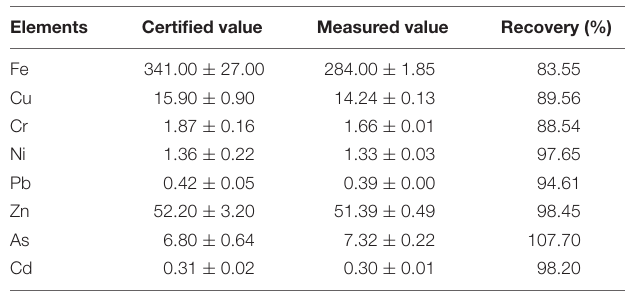
TABLE 2 | Measured and certified values of elemental concentrations (Fe, Cu, Cr, Ni, Pb, Zn, As, and Cd) for certified reference material DORM-4